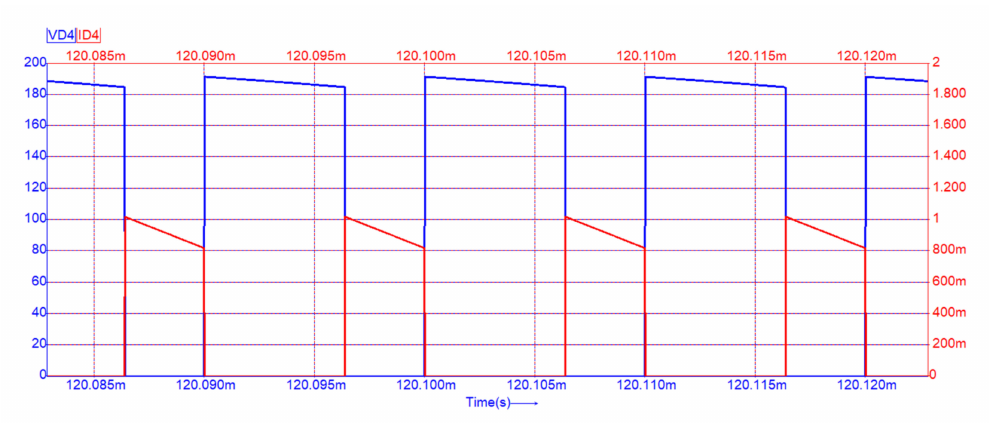
Figure 18. Voltage and current corresponding to the diode D 4